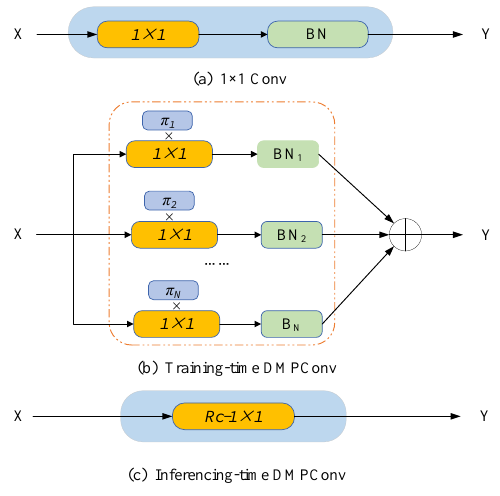
Figure 1. Overview of